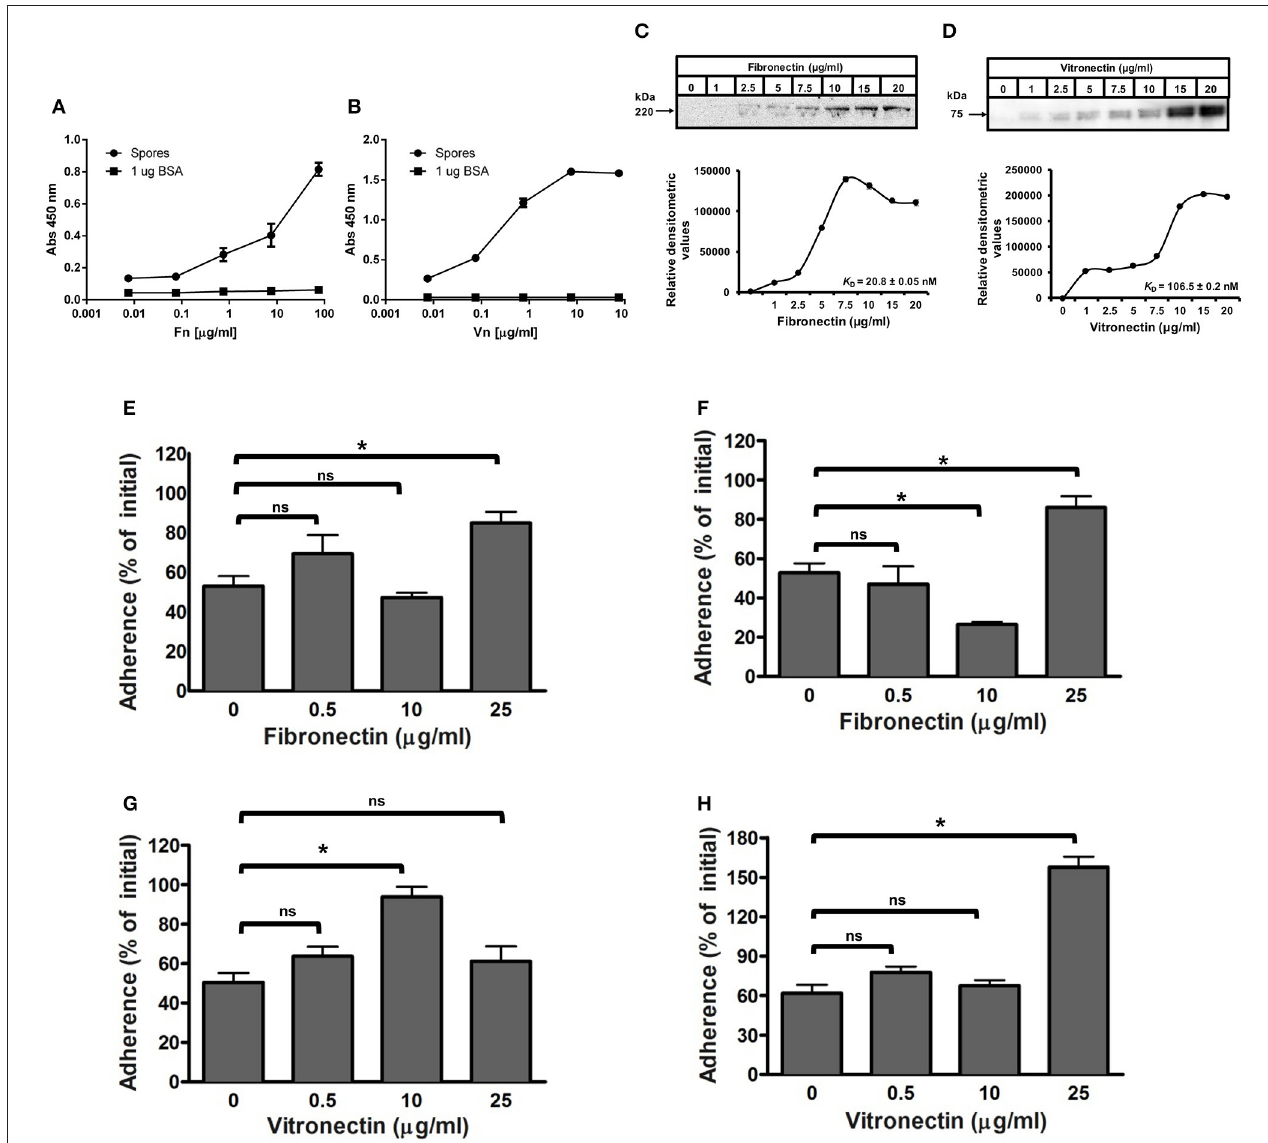
FIGURE 4 | Effect of binding of fibronectin and vitronectin to C. difficile R20291 spores in the adherence to intestinal epithelial cells. (A,B) Solid phase binding affinity of fibronectin (A) and vitronectin (B) to C. difficile spores was assessed in spore- (black circles) or BSA-coated wells (black squares) as a control. Coated wells were then incubated with various concentrations of fibronectin (Fn) and vitronectin (Vn) for 1h at 37 ◦ C and bound protein was detected as outlined in the Method section. The binding affinity of fibronectin (C) and vitronectin (D) to C. difficile wild-type R20291 spores was determined by incubating 4 × 10 7 spores with various concentrations of fibronectin and vitronectin for 1h at 37 ◦ C prior to resolving bounded molecules by SDS-PAGE gels, followed by Western blotting using fibronectin and vitronectin antibodies. Relative densitometric analysis of bounded fibronectin (C) and vitronectin (D) was performed to estimate the dissociation constant ( K D ) as described in the Method section using the background noise of 0 µ g/ml of fibronectin and vitronectin as the reference values. Representative Western blots from three independent experiments are shown in (A,B) . Data represents the average of three independent experiments. (E–H) Effect of fibronectin and vitronectin on the adherence of C. difficile spores to intestinal epithelial cells. C. difficile spores were preincubated with various concentrations of fibronectin (E,F) and vitronectin (G,H) for 1h at 37 ◦ C prior to infecting monolayers of undifferentiated (E,F) and differentiated (G,H) Caco-2 cells for 1h at 37 ◦ C. Unbound spores were rinsed off and the percentage of adhered spores was calculated as described in the Method section. Data is the average of three independent experiments and error bars represents standard error of the mean. Student’s t -test was used to compare the effect of fibronectin and vitronectin relative to the control. Asterisks (*) denote statistical difference with P < 0.01, respectively; ns, not significant (Student’s t -test).